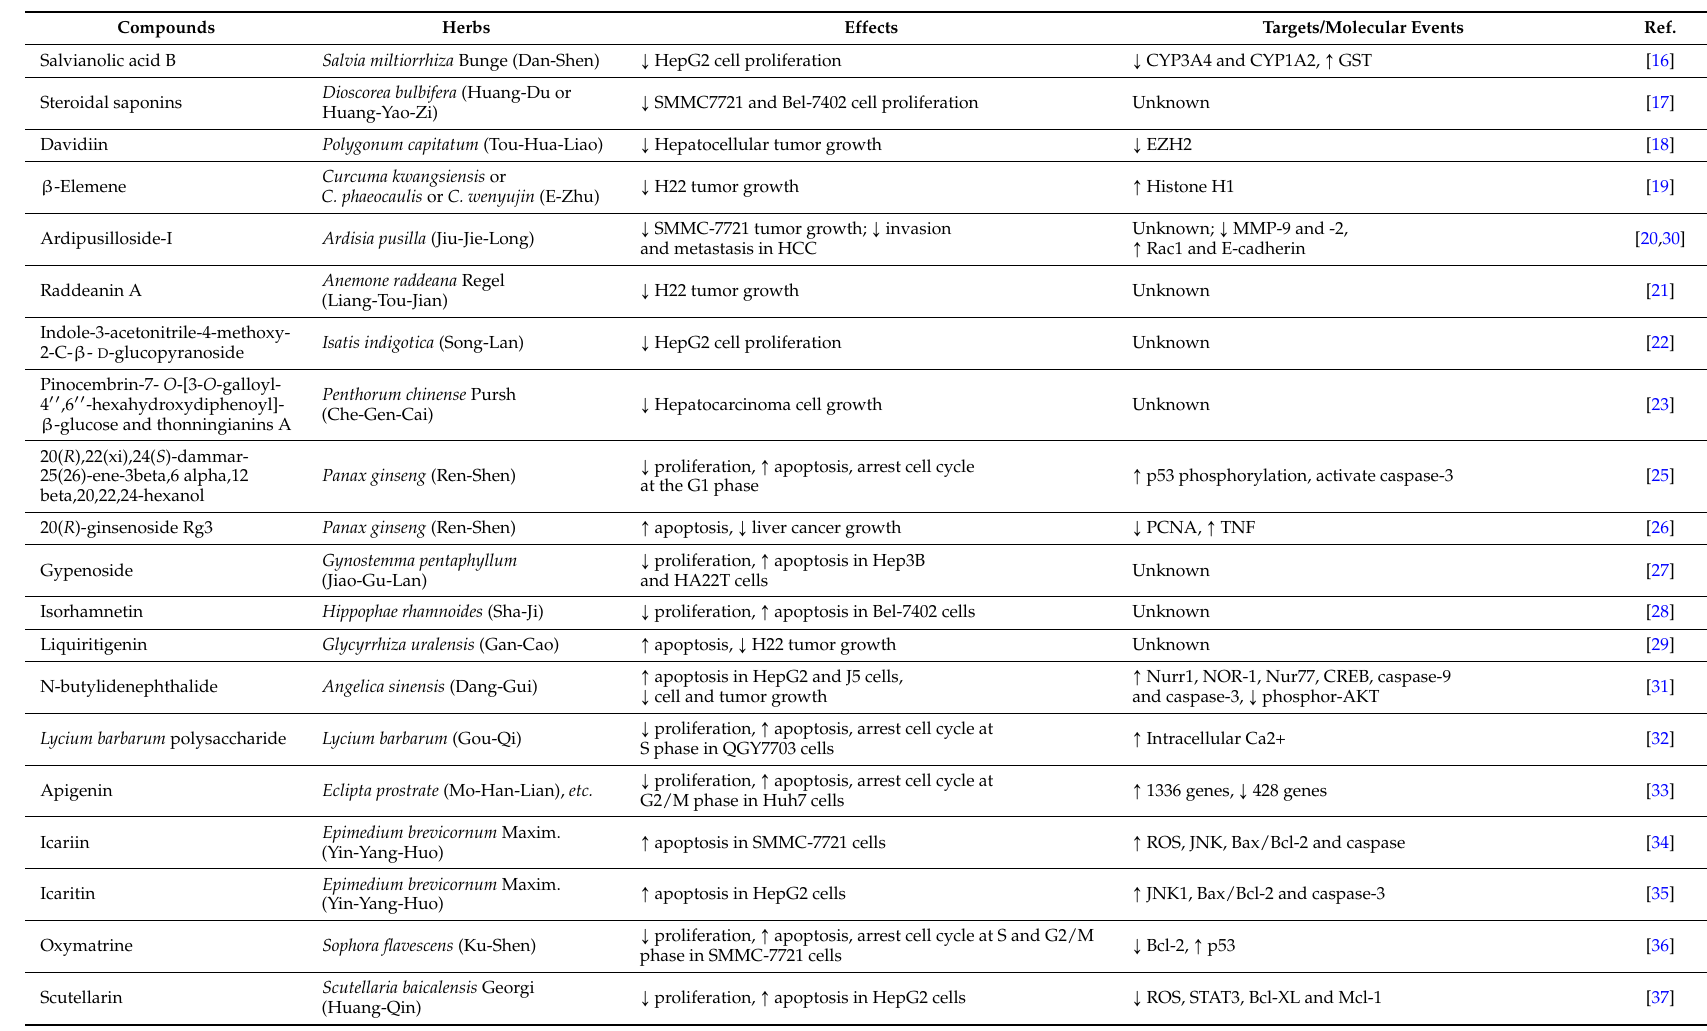
Table 2. Direct anticancer effects of herbal compounds against